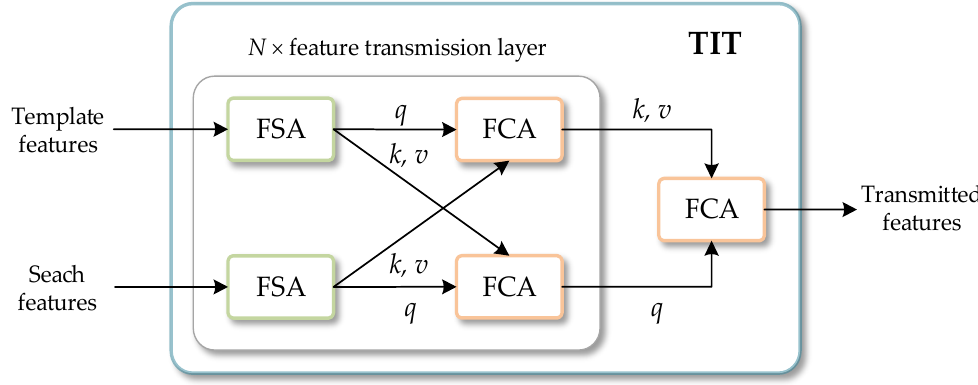
Figure 5. The structure of TIT. FSA represents the Feature Self-Augment module, and FCA means the Feature Cross-Augment module.